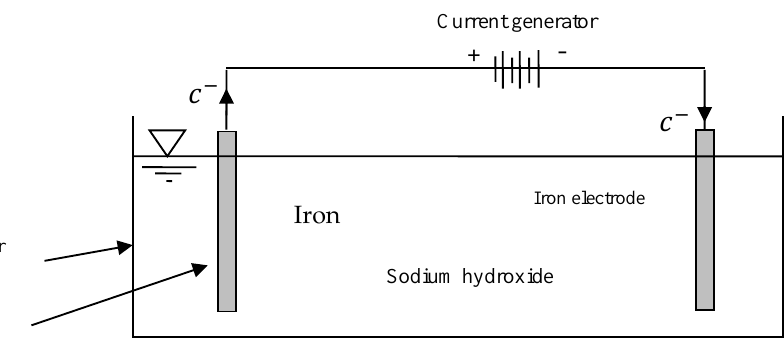
Figure 2. Schematic of the electrochemical cell for ferrate (VI) synthesis.